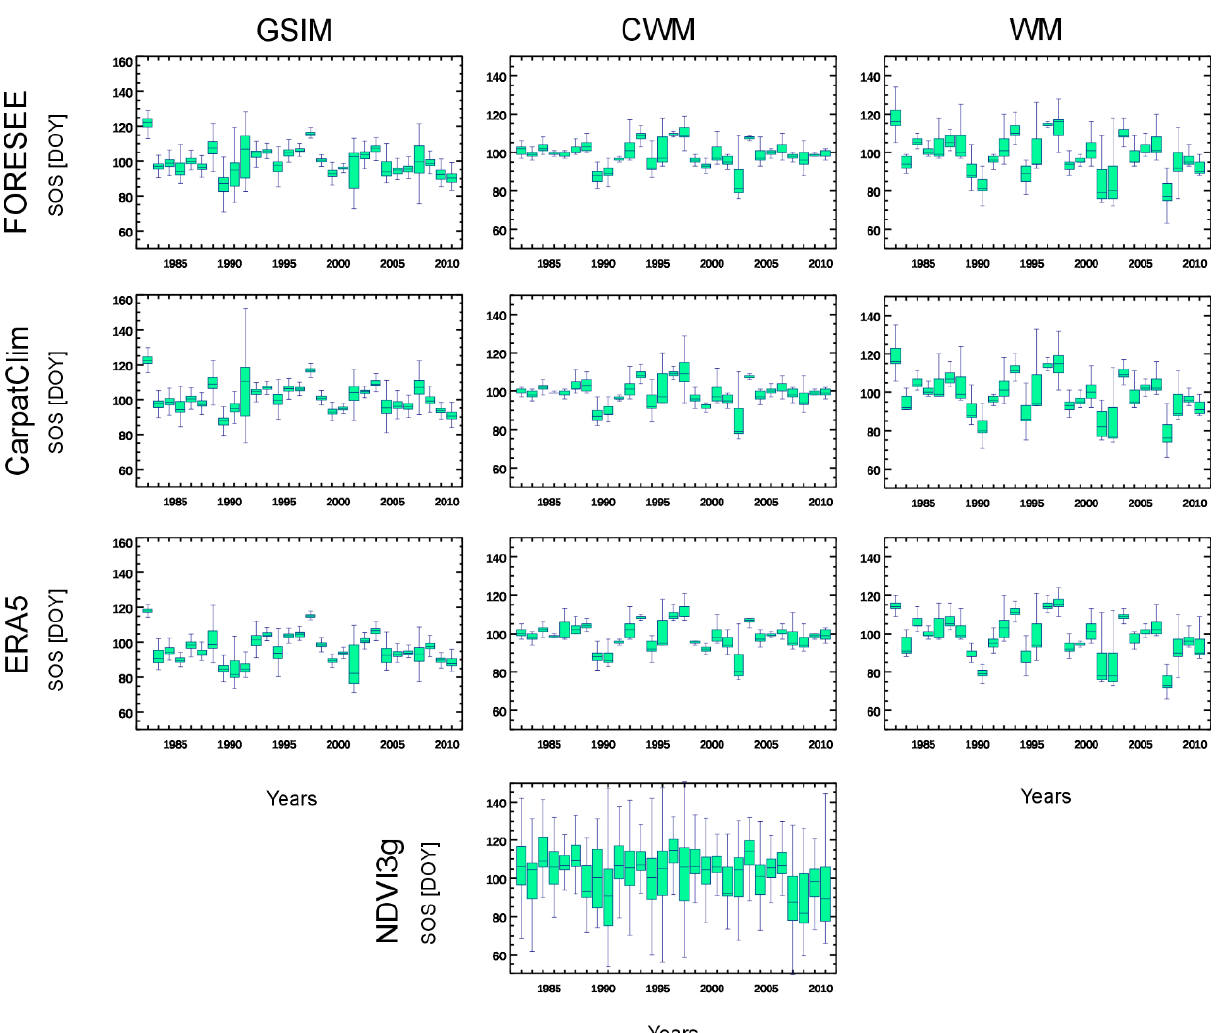
Figure 3. Box-whisker plots showing spatial and temporal variability of the SOS estimation for the whole study area (1539 pixels). The green bars represent the 25th and 75th percentiles, while the lines within the bars represent the median values and the whiskers show extreme values within 1.5 times of the interquartile range.